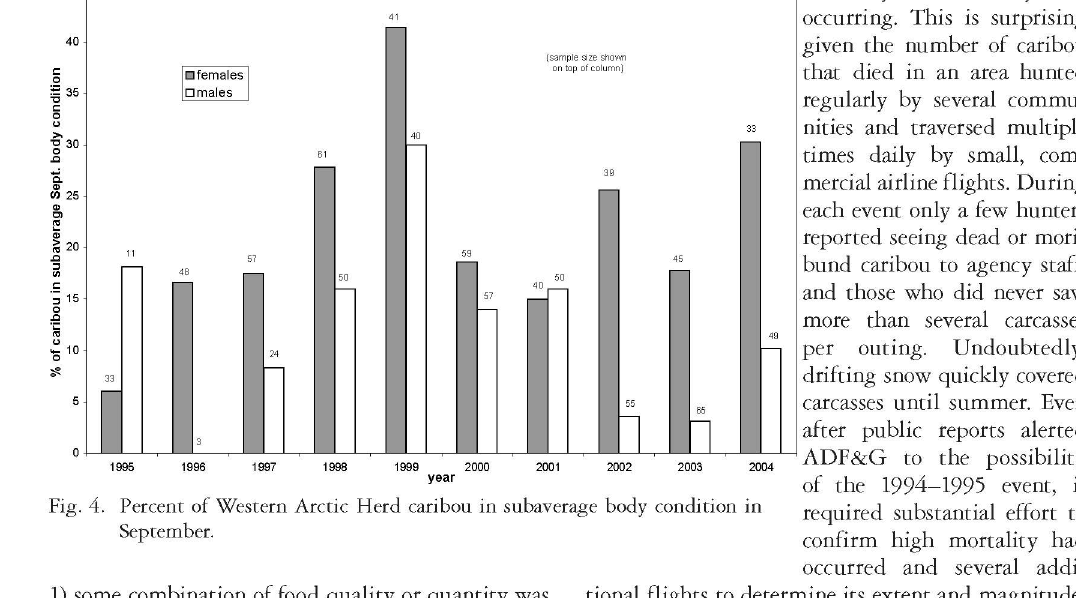
Fig. 4. Percent of Western Arctic Herd caribou in subaverage body condition